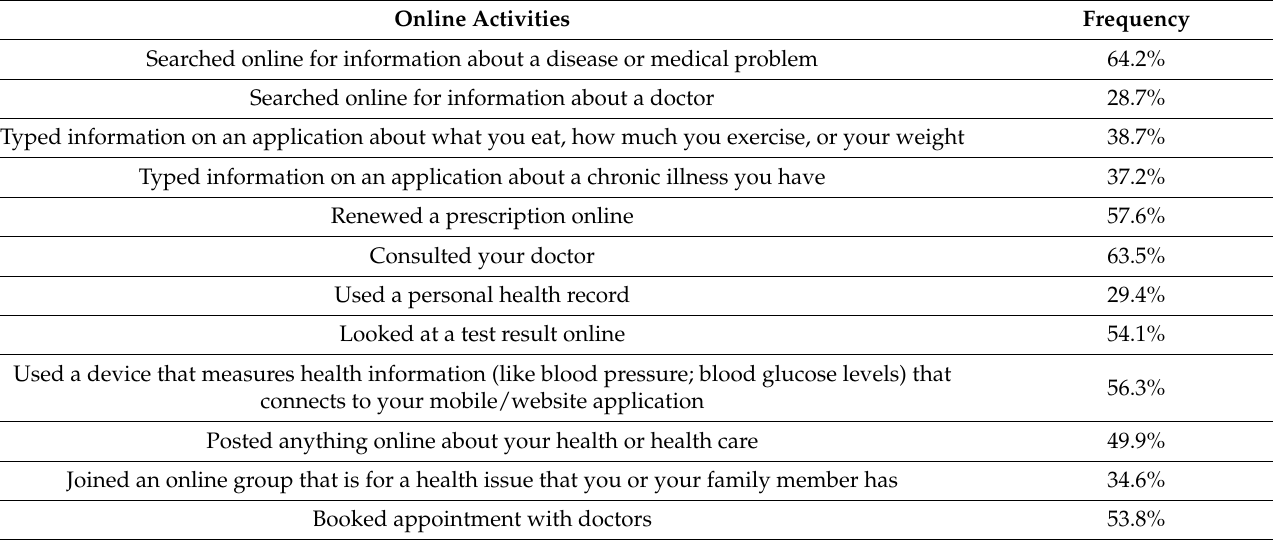
Table 2. Online behavior of the participants.